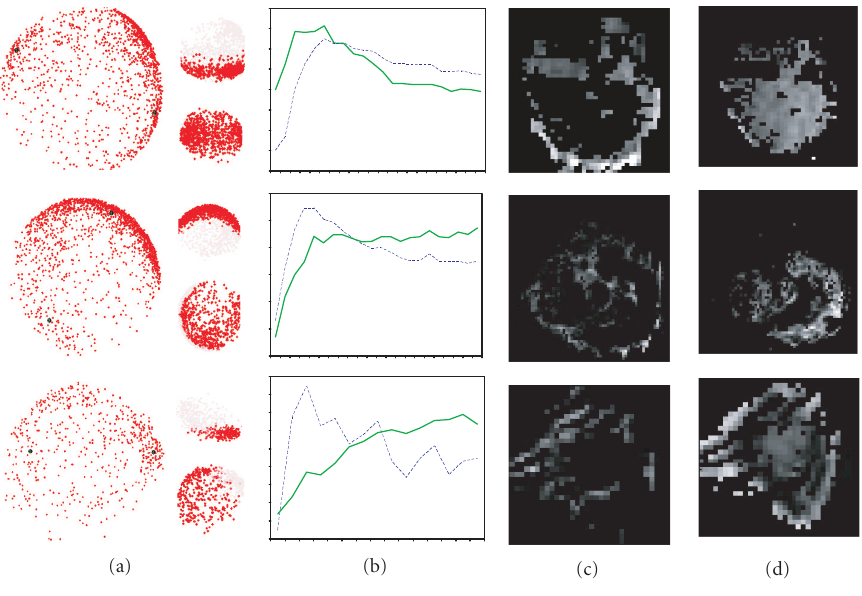
Figure 8: Blind decomposition of permeability distribution and di ff usion dynamics via CCA in a longitudinal study with three-time snap- shots shown in Figure 7. (a) 2D projection of compartment TAC clusters and 2D projection of individual compartment TAC clusters; (b) TACs corresponding to fast and slow flows/perfusions; and (c) and (d) extracted angiogenic permeability distributions (source images) as- sociated with fast and slow flows/perfusions. Serving as the quantitative measures for monitoring functional response to therapy, the results correspond to a positive responsive case where both fast and slow di ff usion/perfusion rates are significantly reduced during and after the